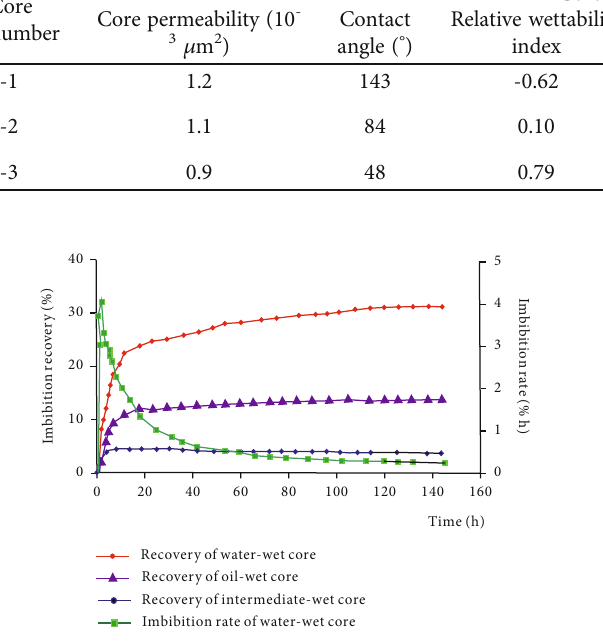
Figure 1: Relationship between static spontaneous imbibition recovery and time. Figure